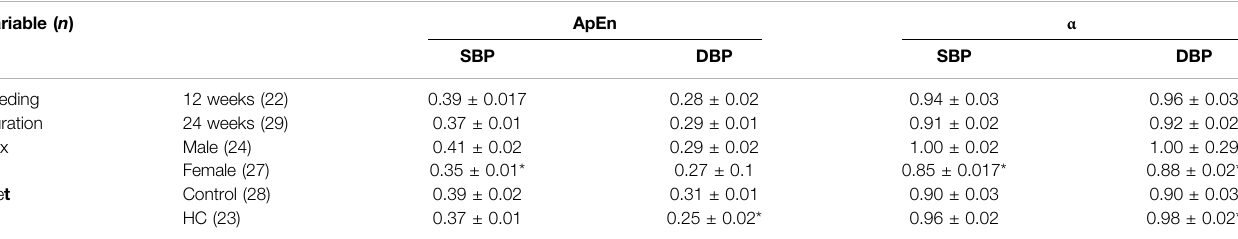
TABLE2| Univariateanalysisofnonlinearvariabilityparametersofbeat-to-beatsystolicanddiastolicbloodpressure(SBPandDBP,respectively)timeseriesacrossdifferent ratgroups.Statisticalanalysiswasdeterminedusing t -testorMann – Whitney U testbasedontheresultsoftheShapiro – Wilktestofnormality.*denotes p < 0.05for12vs. 24 weeks, males vs. females, or control vs. HC. Variable ( n